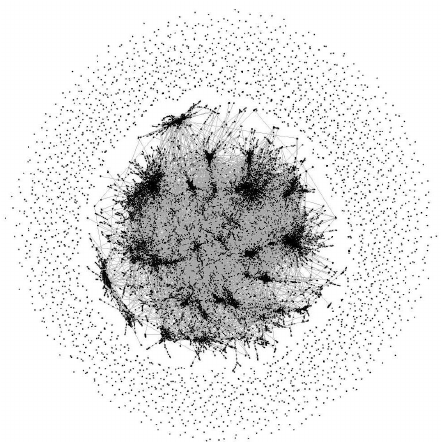
Figure 1. Phone call network dataset.